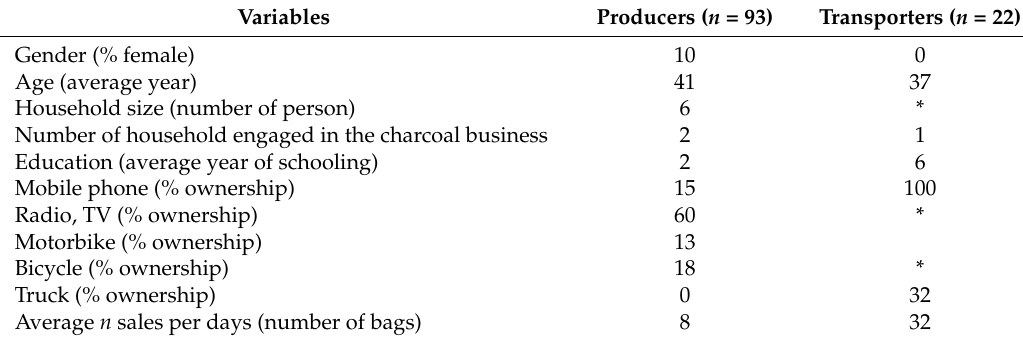
Table 1. Characteristics of the respondents.